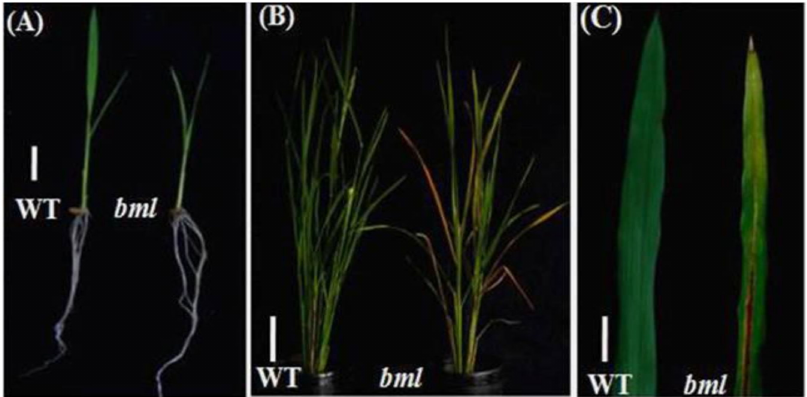
Figure 1. Phenotypic characterization of brown midrib leaf ( bml ) mutant and wild-type (WT) rice plants. ( A ) Morphologically similar phenotypes observed in bml and WT at the seedling stage. Bar = 2 cm. ( B ) Phenotypes of bml and WT at the heading stage. Bar = 10 cm. ( C ) Enlarged view of part of the second leaves from the top of the plant shown in (B). Bar = 5